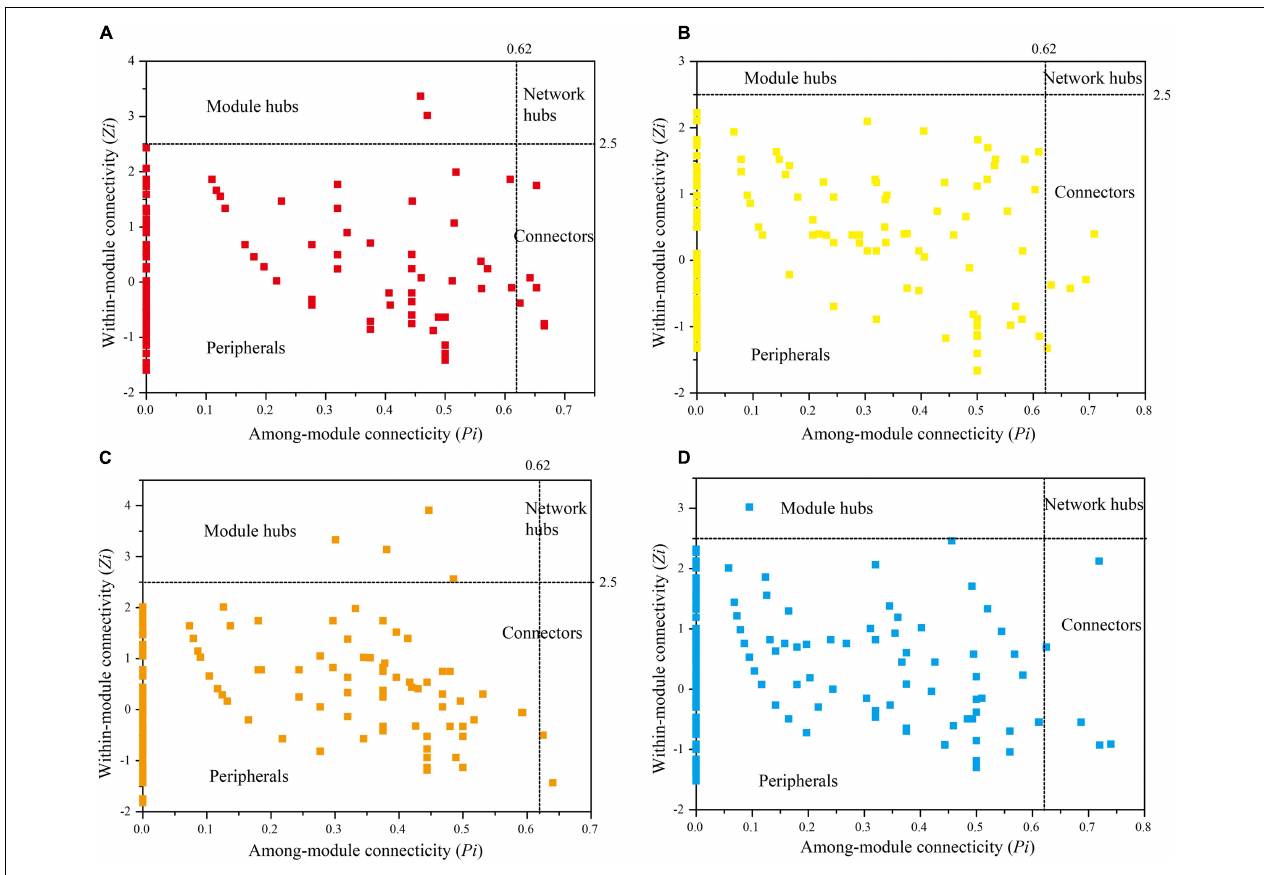
FIGURE 7 | Zi - Pi plot of 2018S (A) , 2018A (B) , 2019S (C) , 2019A (D) bacterioplankton networks.